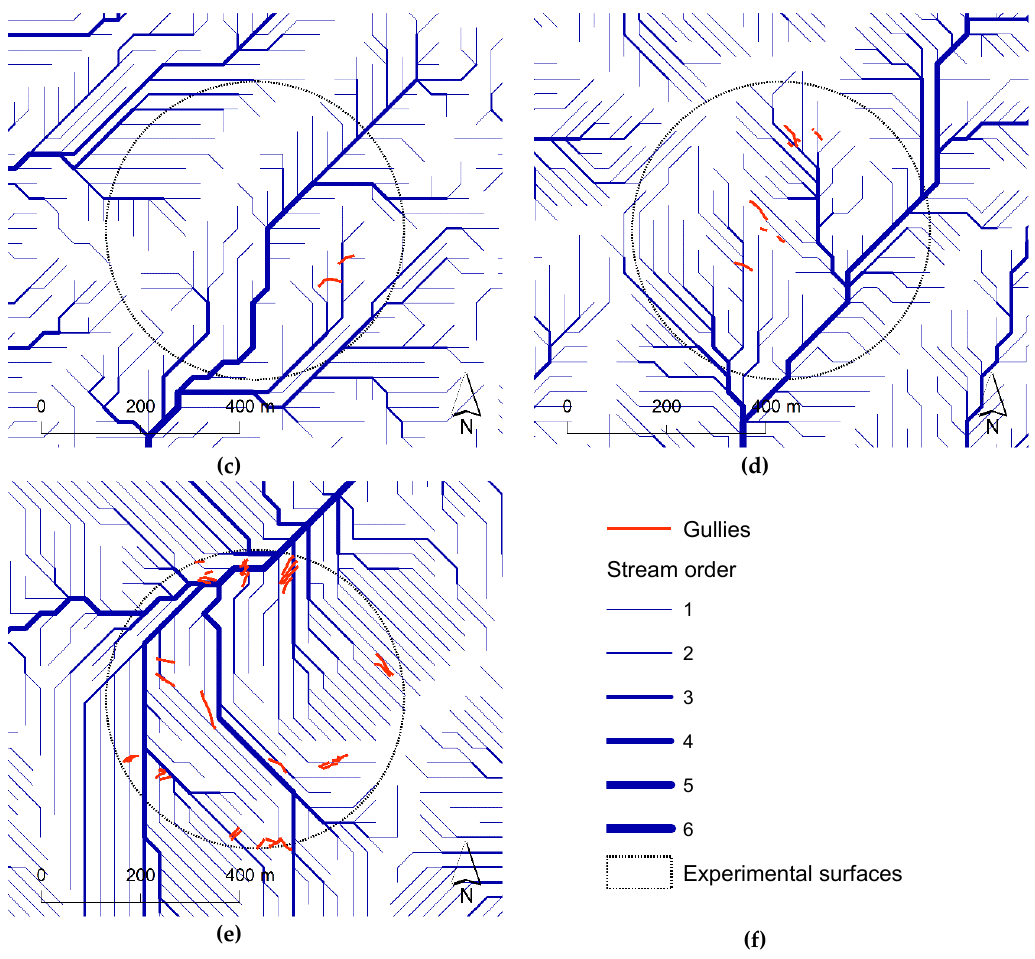
Figure 9. Indicative cases of detected gullies overlaid on the drainage network ( a ) variety of gullies in a 4.5% slope vines - arable land complex, close to Thiva (38°17 ′ 8.45 ″ N/23°27 ′ 1.68 ″ E, 20 February 2014); ( b ) the longest detected gully in a 4.4% slope naked arable soil, close to Almyros (39°10 ′ 55.07 ″ N/22°40 ′ 36.56 ″ E, 28 October 2013); ( c ) short gullies in a 2% slope arable land, close to Agrinio (38°33 ′ 59.95 ″ N/21°23 ′ 35.14 ″ E, 9 September 2009); ( d ) moderate gullies in 11.4% slope olive groves, close to Gerakini (40°18 ′ 56.41 ″ N/23°25 ′ 45.34 ″ E, 3 November 2016); ( e ) highly dense gully pattern in a 29.2% slope olive-vines complex, close to Egio (38°33 ′ 59.95 ″ N/21°23 ′ 35.14 ″ E, 9 July 2009); ( f ) legend.